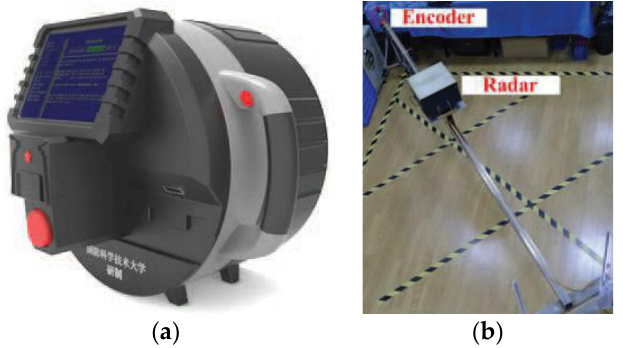
Figure 18. (a) HSR for mine detection [10]; (b) Experimental setup with spatial encoder. Figure 18. ( a ) HSR for mine detection [10]; ( b ) Experimental setup with spatial